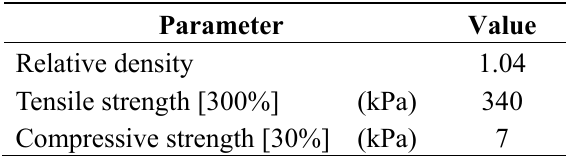
Table 1. Solid state parameters of polyurethane